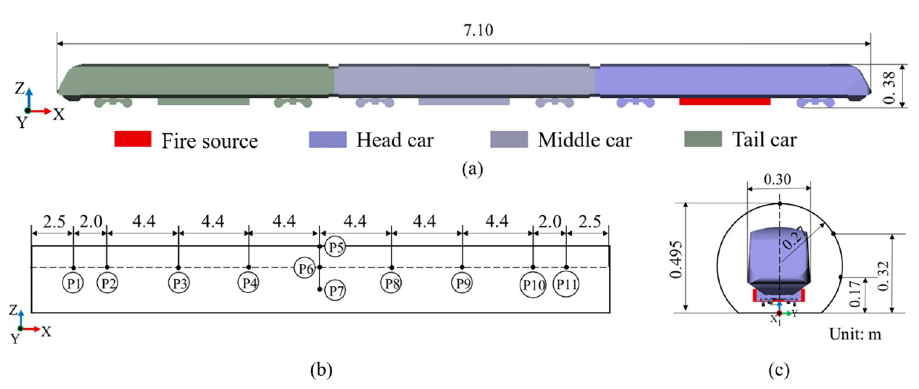
Fig 6. Train and tunnel model diagram with the arrangement of measurement points in the